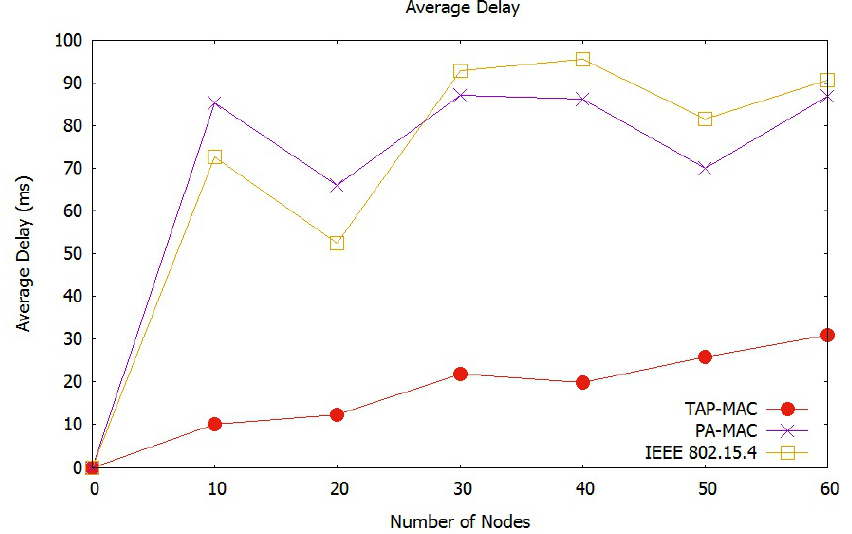
Figure 9. Scenario 1: Average network